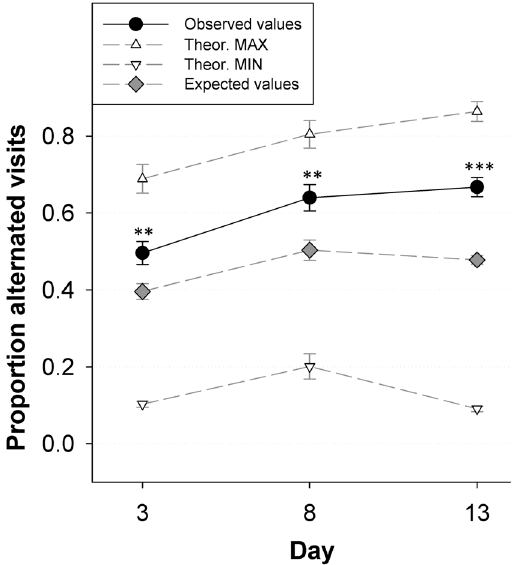
Figure 2. Temporal variation in nest visit alternation. Observed values are population averages ( ± SE) per day and are represented by the black dots and solid line. The mean between the theoretical maximal (white triangles pointing up) and minimal (white triangles pointing down) alternation value was calculated for each observation and is considered the expected proportion of alternated nest visits by chance (grey diamond symbols), taking into account the observed parental nest visits (details see methods). The observed proportion of alternated visits increased with nestling age and were consistently higher than the expected values. Daily Tukey-corrected post-hoc differences between empirical and expected samples are indicated as ** (0.01 < P < 0.001) and *** (P <